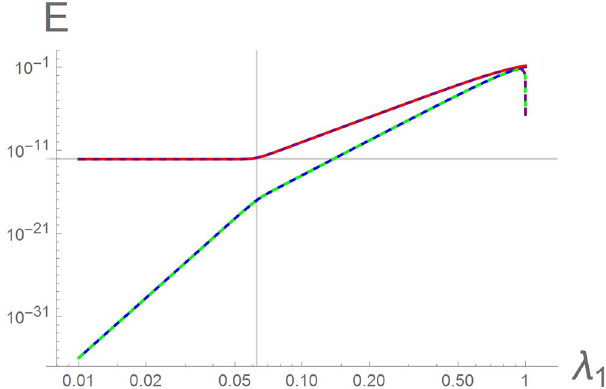
 of the two lowest-lying excited states of the Ising-Kitaev chain (1)–(2) in the Figure 3. Energy eigenvalues 1,2 piece-wise uniform applied field (3) as a function of λ 1 = λ 3 with λ 2 = 4 for N 1 = 10, M = 20, and N 2 = 14. The solid curves represent the result of the exact numerical diagonalization. The dashed lines represent the analytic solutions to Eqs (34) and (35). The vertical grid line corresponds to λ λ = − N M 12 = 1/16. On the right side of this line the green dashed line corresponds to Eq. (6) and the purple – to Eq. (7). λ 1 On the left side the green dashed line represents Eq. (9), the purple – Eq. (8). The horizontal grid line 20 . corresponds to λ = = − − E 4 M 2